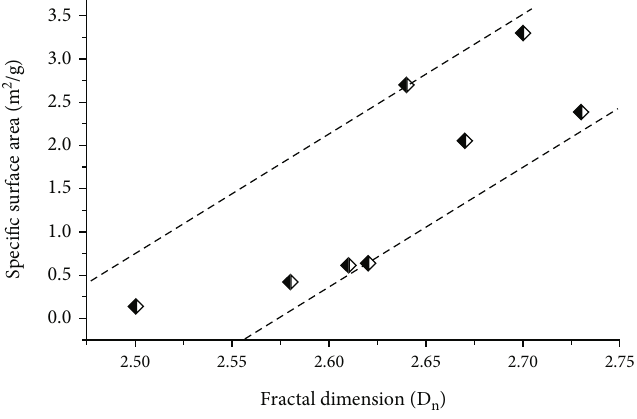
Figure 13: Relationship between total speci fi c surface areas and fractal dimension D